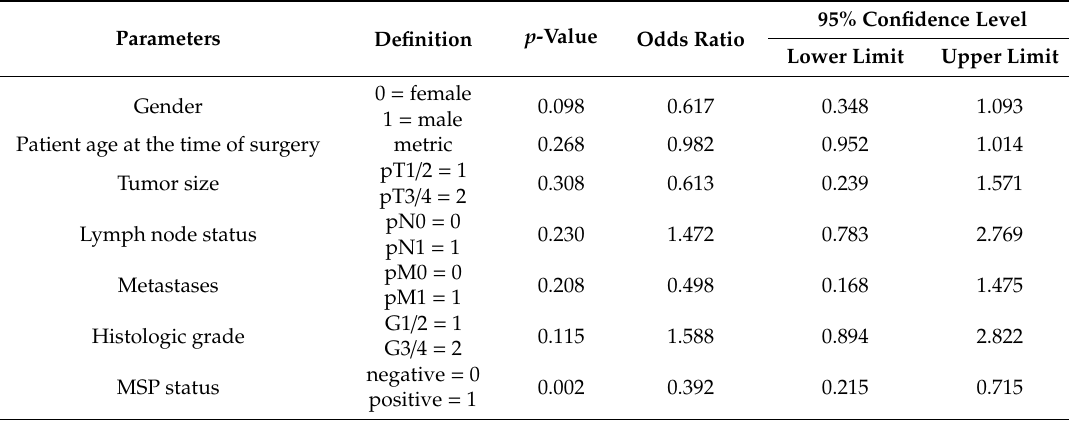
Table 3. Clinical parameters and their respective strength of association for survival in our patient collective (MSP = methylation-specific